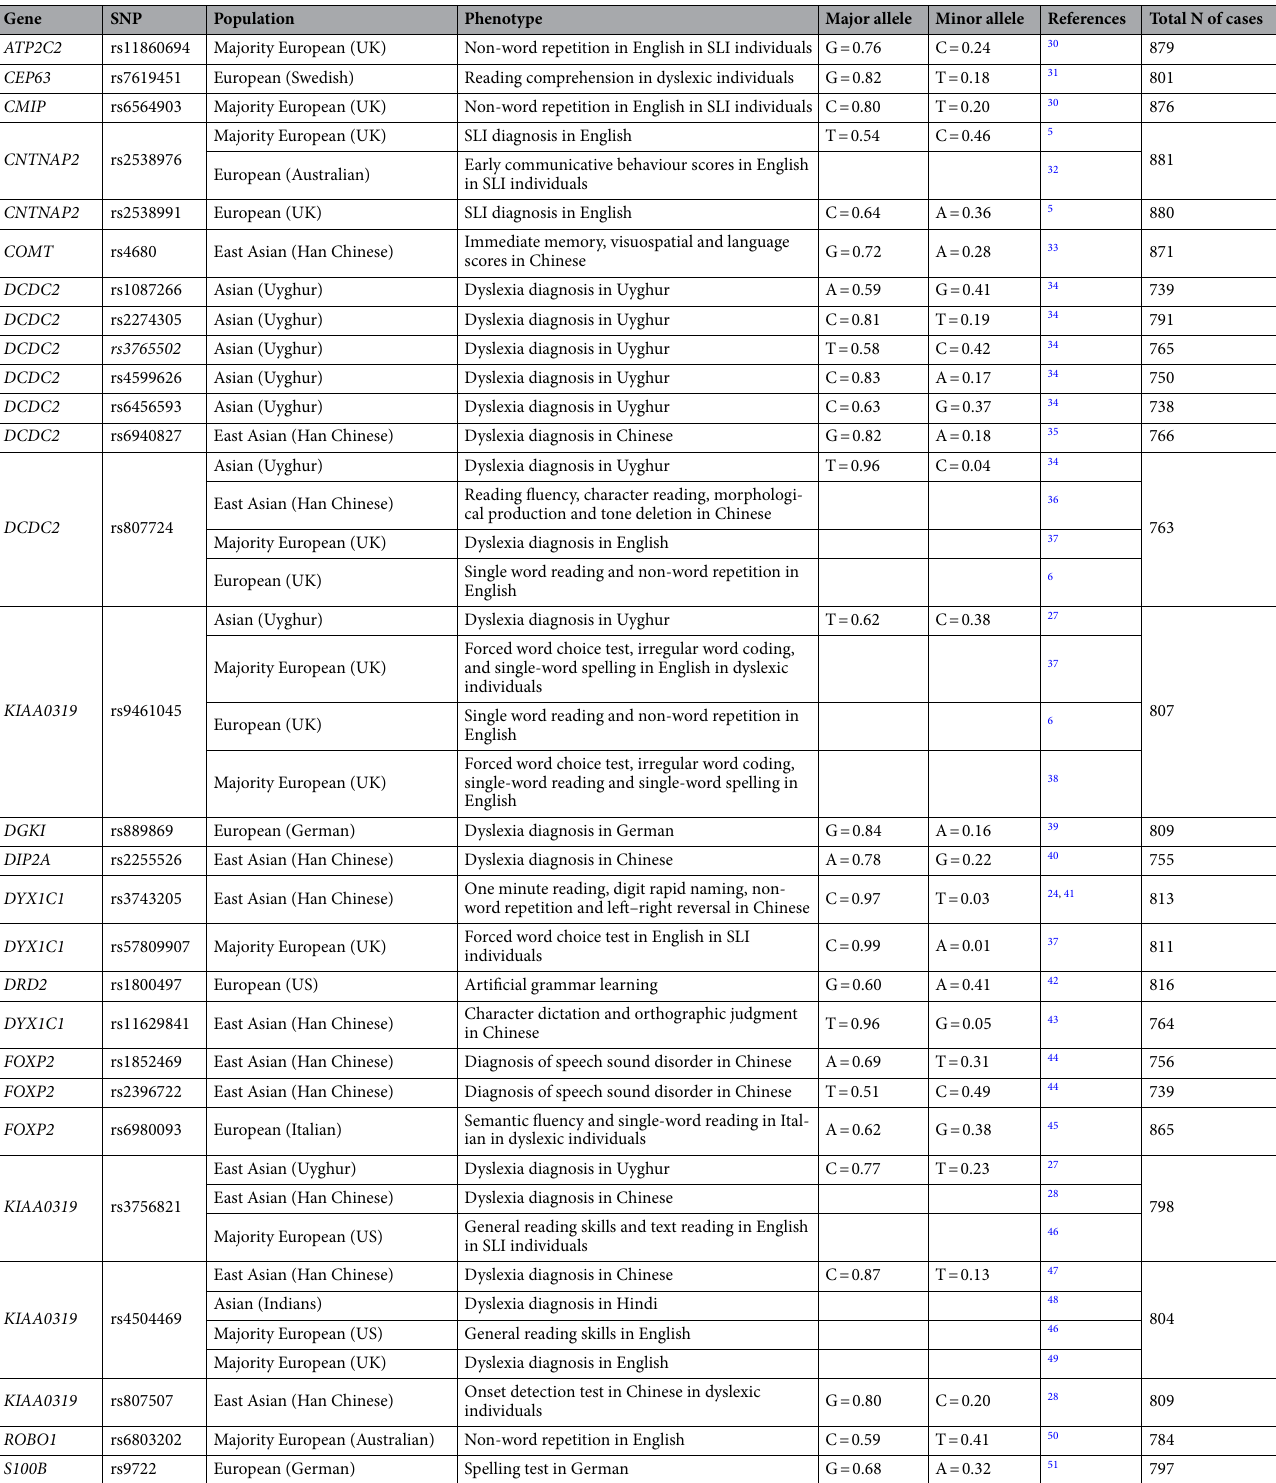
Table 1. SNPs of language-related genes hypothesized to be associated with language proficiency that we examined in the present study. Major and minor allele frequencies are those in our sample. Examples of relevant studies for each gene are listed under